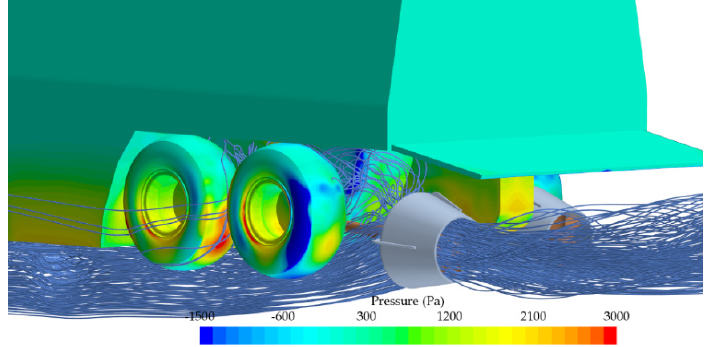
Figure 25. Inflow of the pump-jets in the initial model.